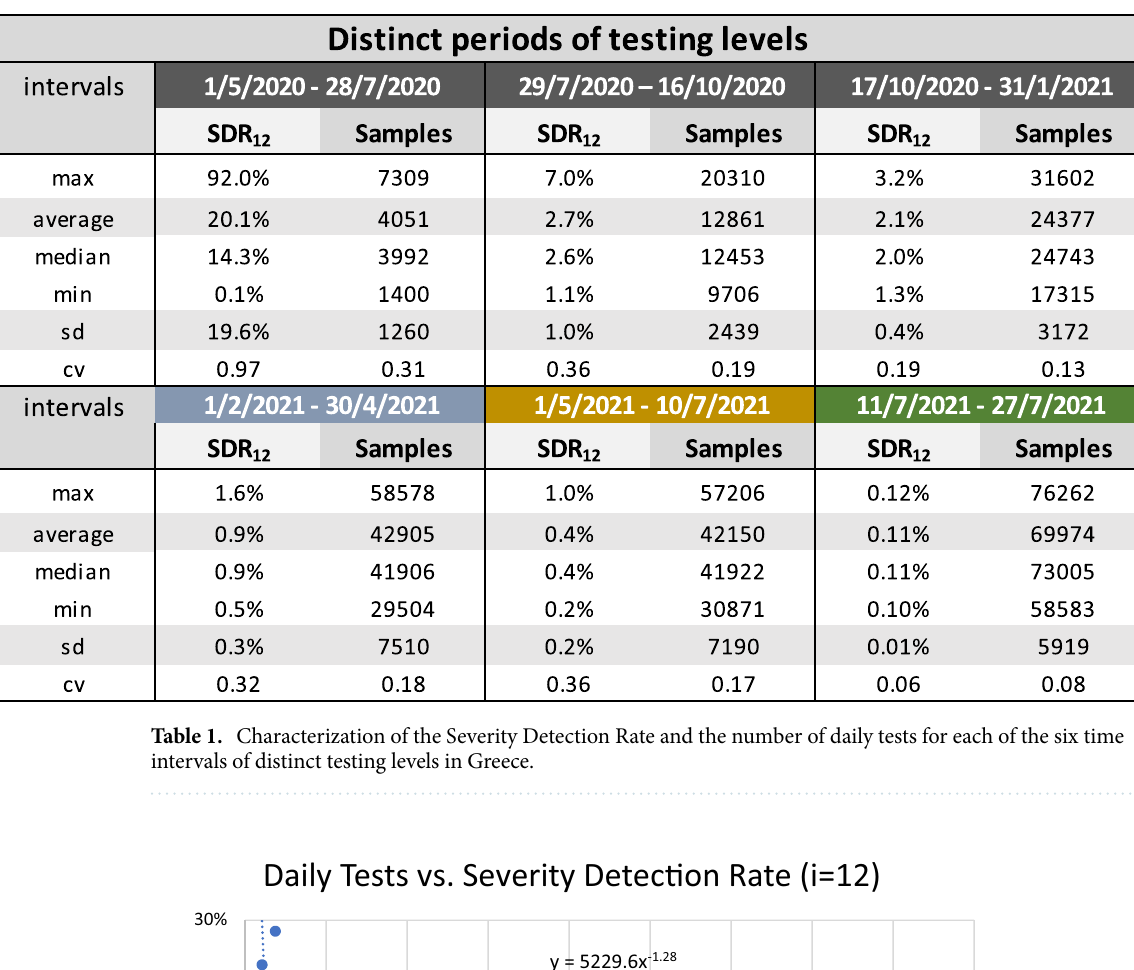
y = 5229.6x -1.28 R² = 0.7928